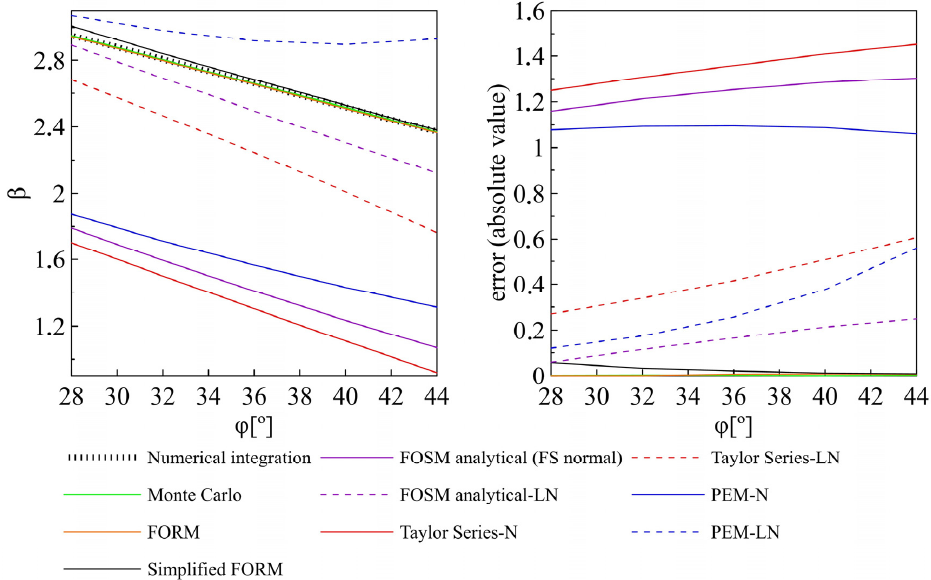
Figure 9. Summary of reliability analysis performed by different methods.